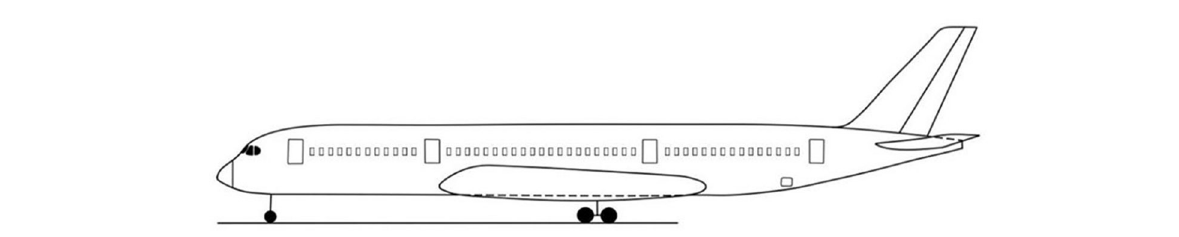
FIGURE7 Schematic diagram of an airliner in the horizontal state.